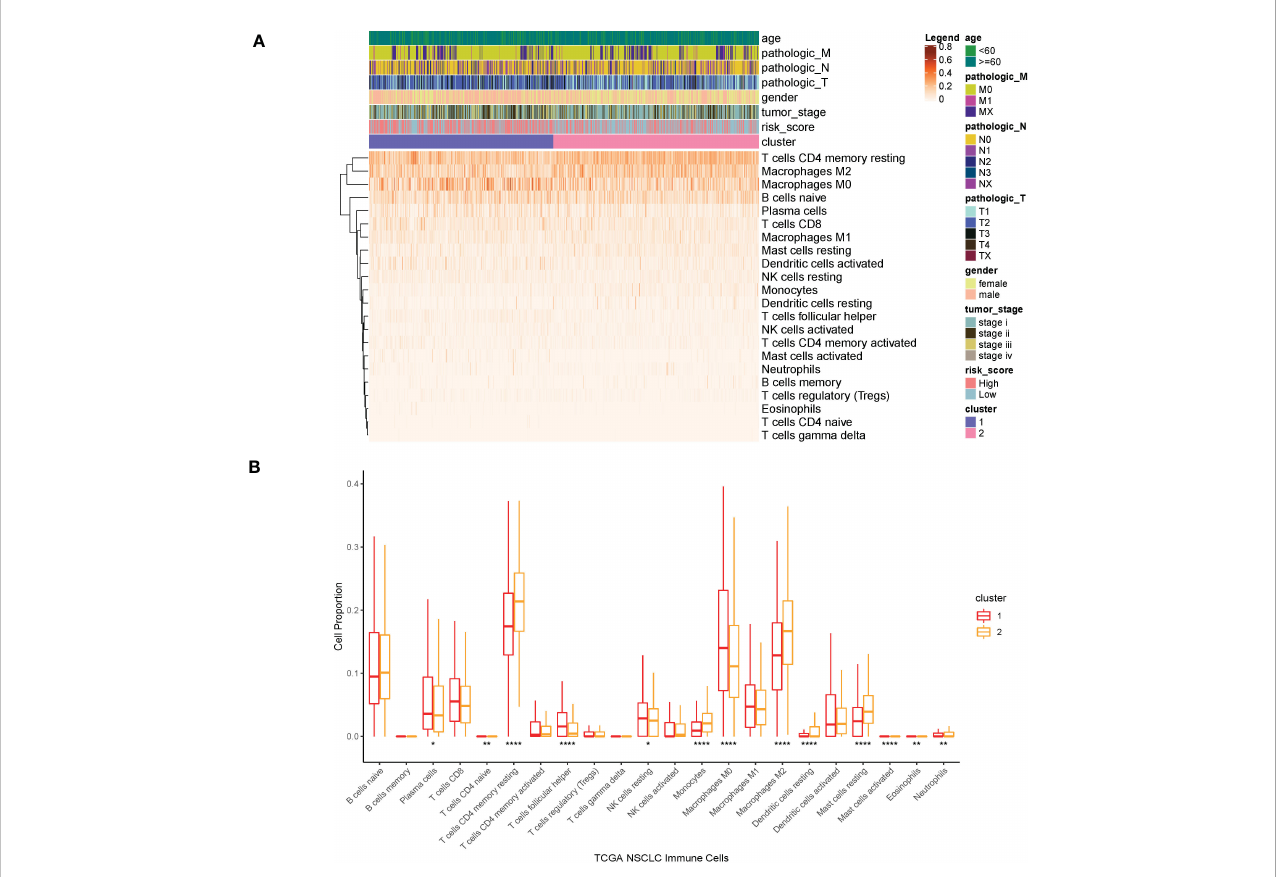
FIGURE 7 (A) Heatmap of clinical factors and in fi ltrated immune cells in the two clusters. (B) Proportion of immune cells in the two clusters. ****p<0.0001, **p<0.01,